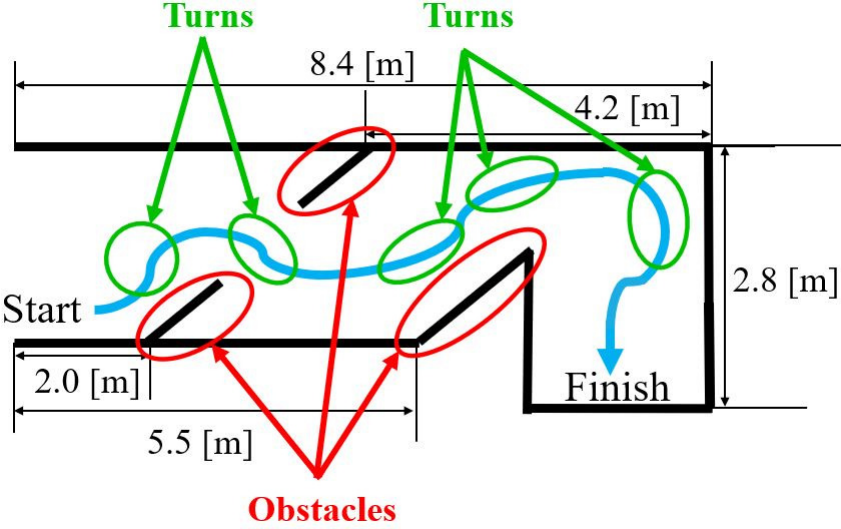
Figure 11. Experimental